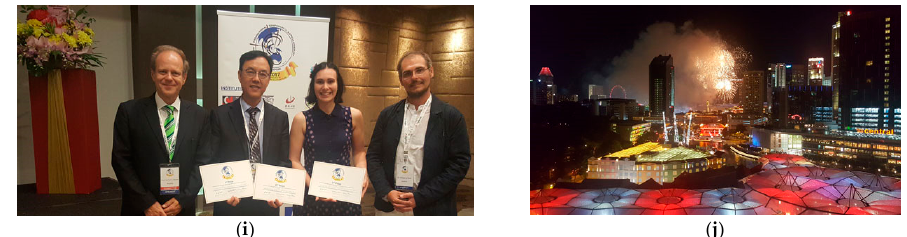
Figure 19. ( a – j ) Ninth International Symposium on Auriculotherapy, Singapore, Republic of Singapore. ( a ) Opening Lecture by Professor Gerhard Litscher. ( b ) Mrs. Dr. Yu-Foo Yee Shoon, former